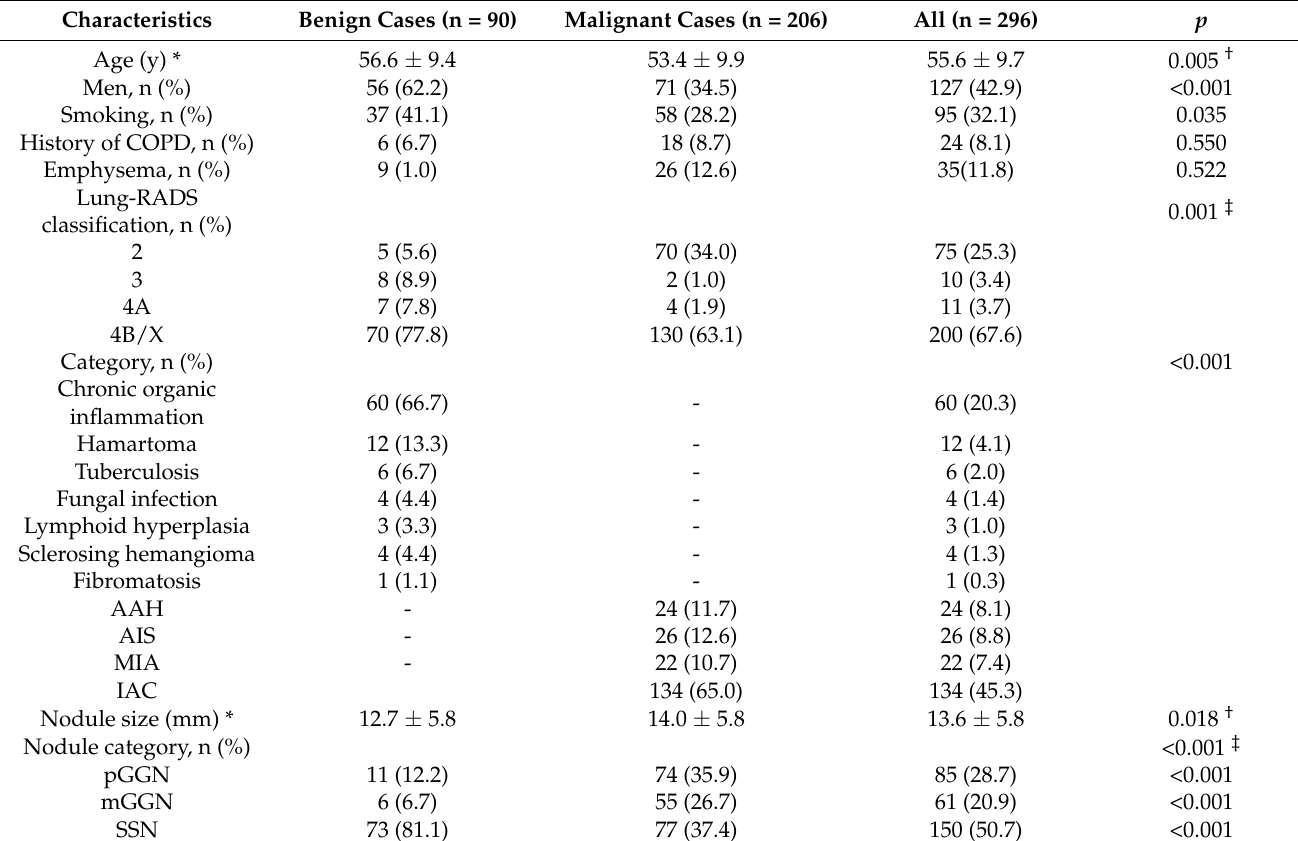
Table 2. Subject